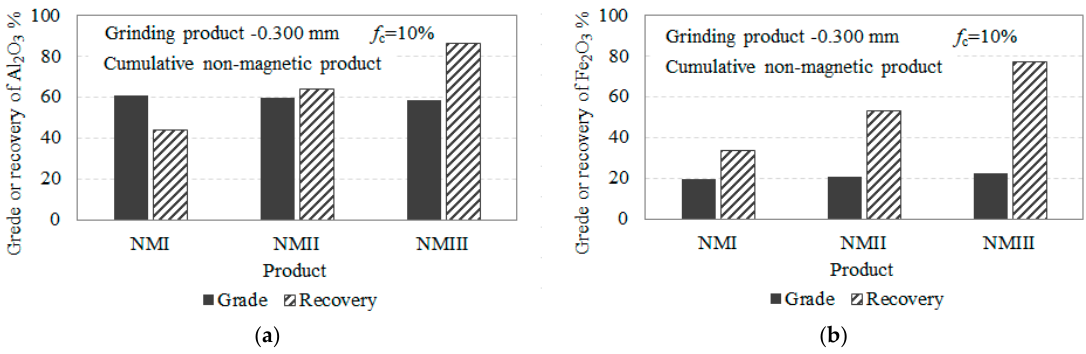
Figure 12. ( a ) Al 2 O 3 grade and recovery and ( b ) Fe 2 O 3 grade and recovery in the cumulative non-magnetic product for the − 0.300 mm fraction when the material filling volume f c was 10%.